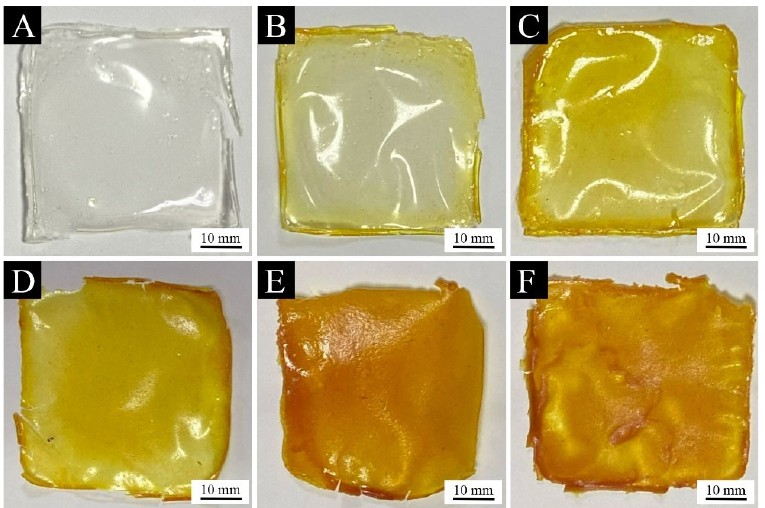
Figure 7. Macro morphology of the paint films: ( A ) 0% microcapsule-loaded film, ( B ) 1.0% microcapsule-loaded film, ( C ) 3.0% microcapsule loaded-film, ( D ) 6.0% microcapsule-loaded film, ( E ) 9.0% microcapsule-loaded film, and ( F ) 12.0% microcapsule-loaded